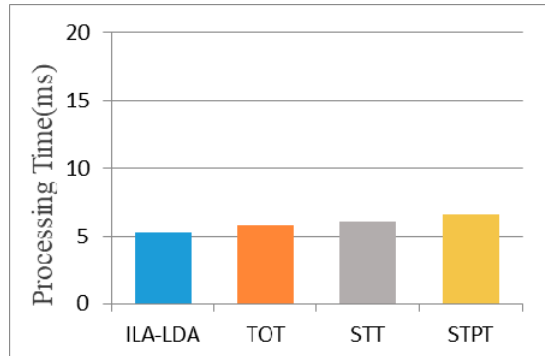
Figure 14. Efficiency with respect to online recommendations.